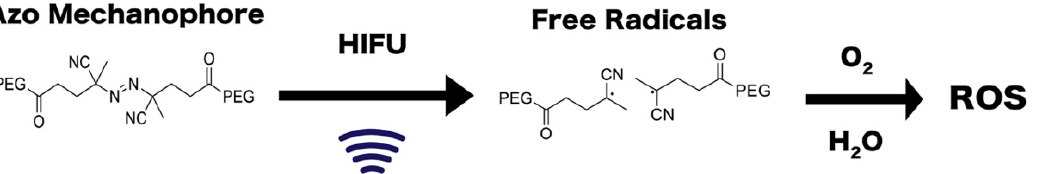
Figure 5. Design of ultrasound-responsive mechanophores embedded into PEG hydrogels, generating reactive oxygen species (ROS) when activated by high-intensity focused ultrasound. This hydrogel matrix was developed by Kim et al. [134] and used for the selective elimination of cancer cells in vitro.